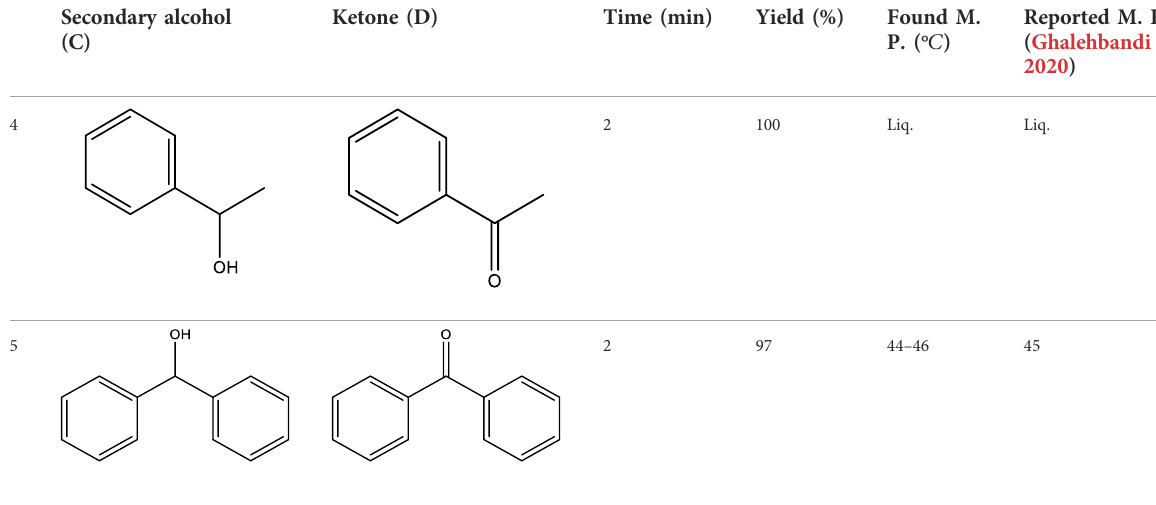
TABLE 3 ( Continued ) Green oxidation of secondary alcohol derivatives to ketone derivatives using CCPSF NPs under MW irradiation.